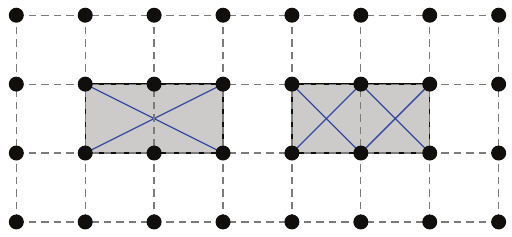
Figure 7: Possible vertex